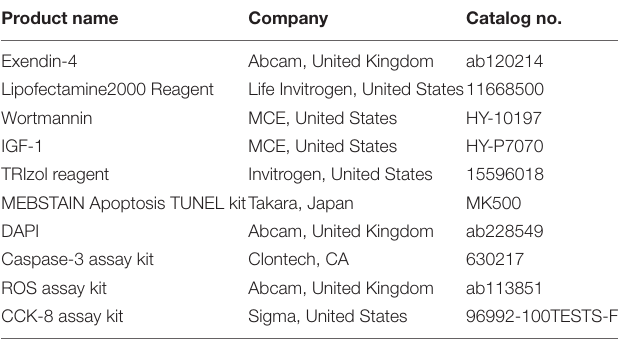
TABLE 2 | Catalog numbers of commercially available kits and